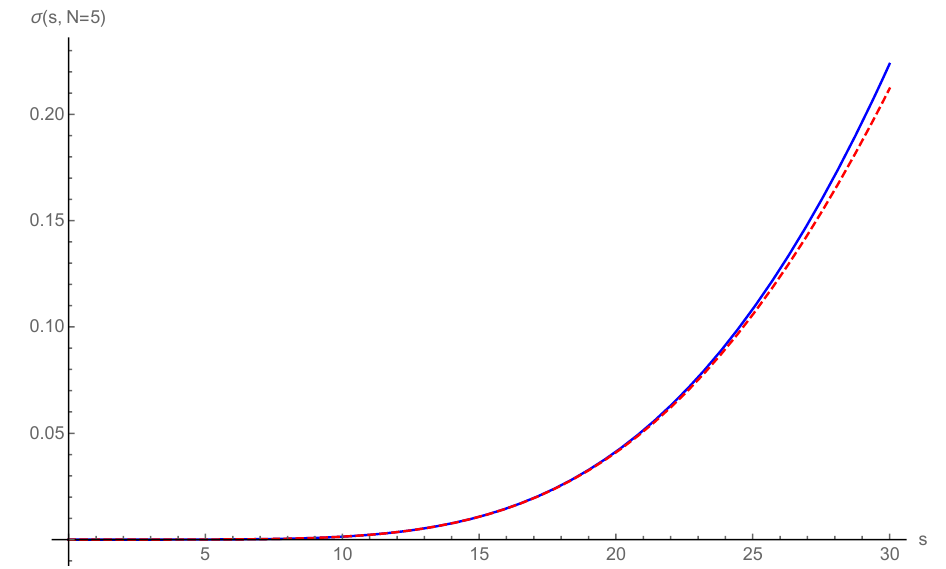
Figure 3 . Comparison of the exact [solid blue curve] Tracy-Widom function (cid:27) N ( s ) in (3.2), for N = 5, with the leading non-perturbative strong-coupling approximation in (3.10). Recall that s (cid:17) x 2 . The agreement is excellent at strong coupling ( s ! 0), and also in the vicinity of the phase transition at s = 5 2